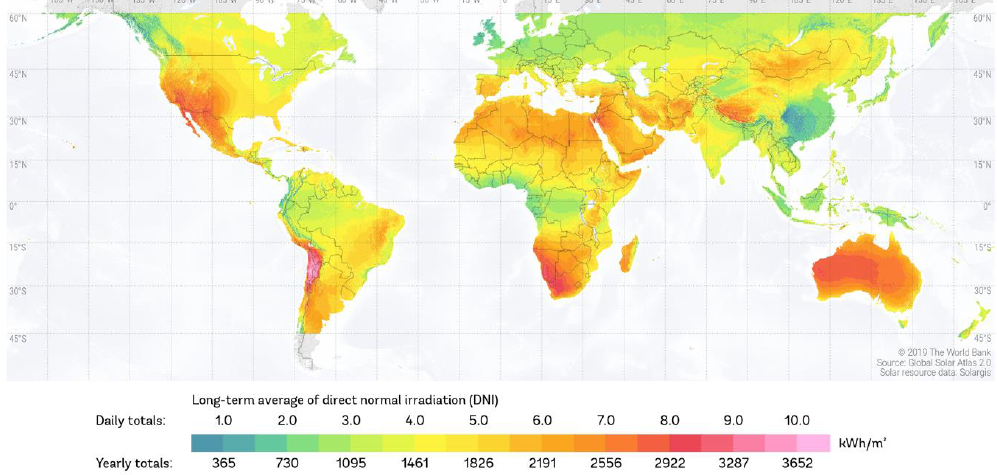
Figure 2. Map of Direct Normal Irradiation [14].